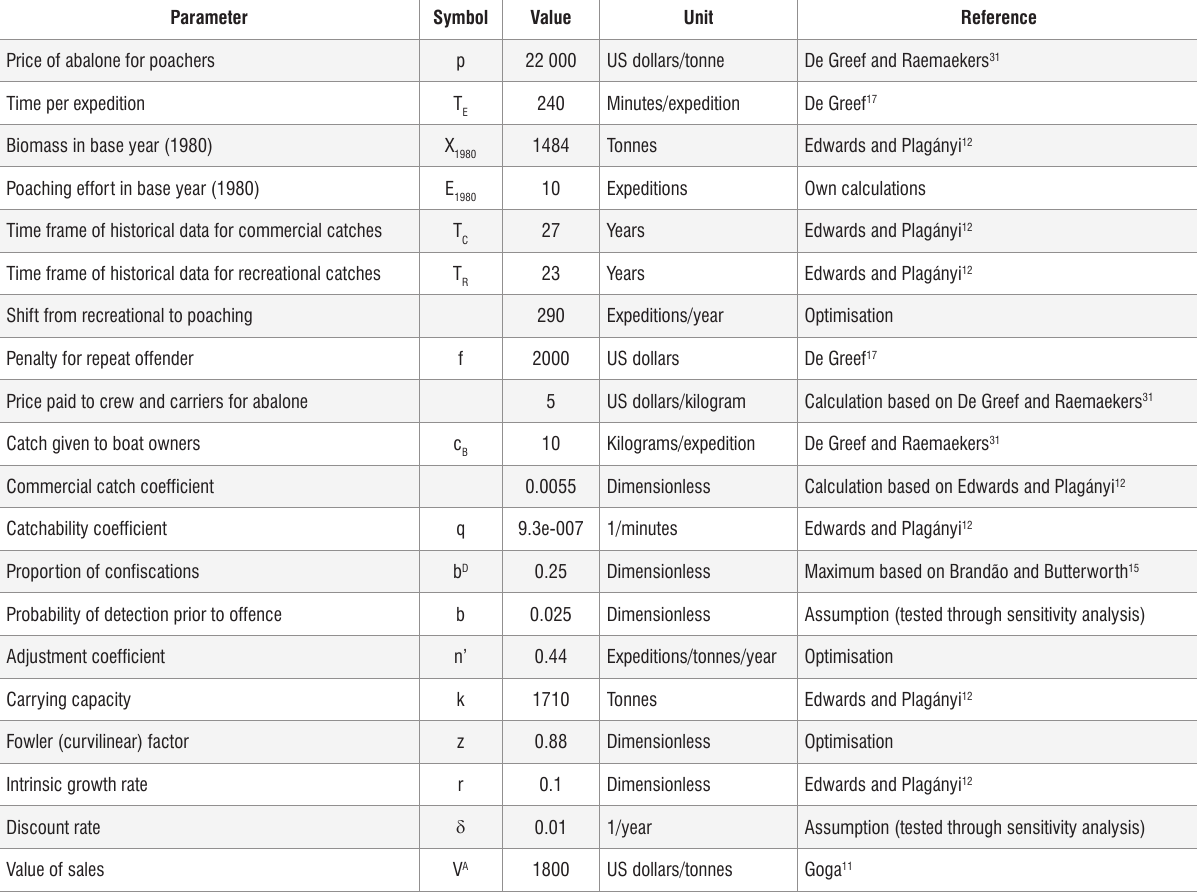
Table 1: Exogenous parameters used in the South African abalone fishery